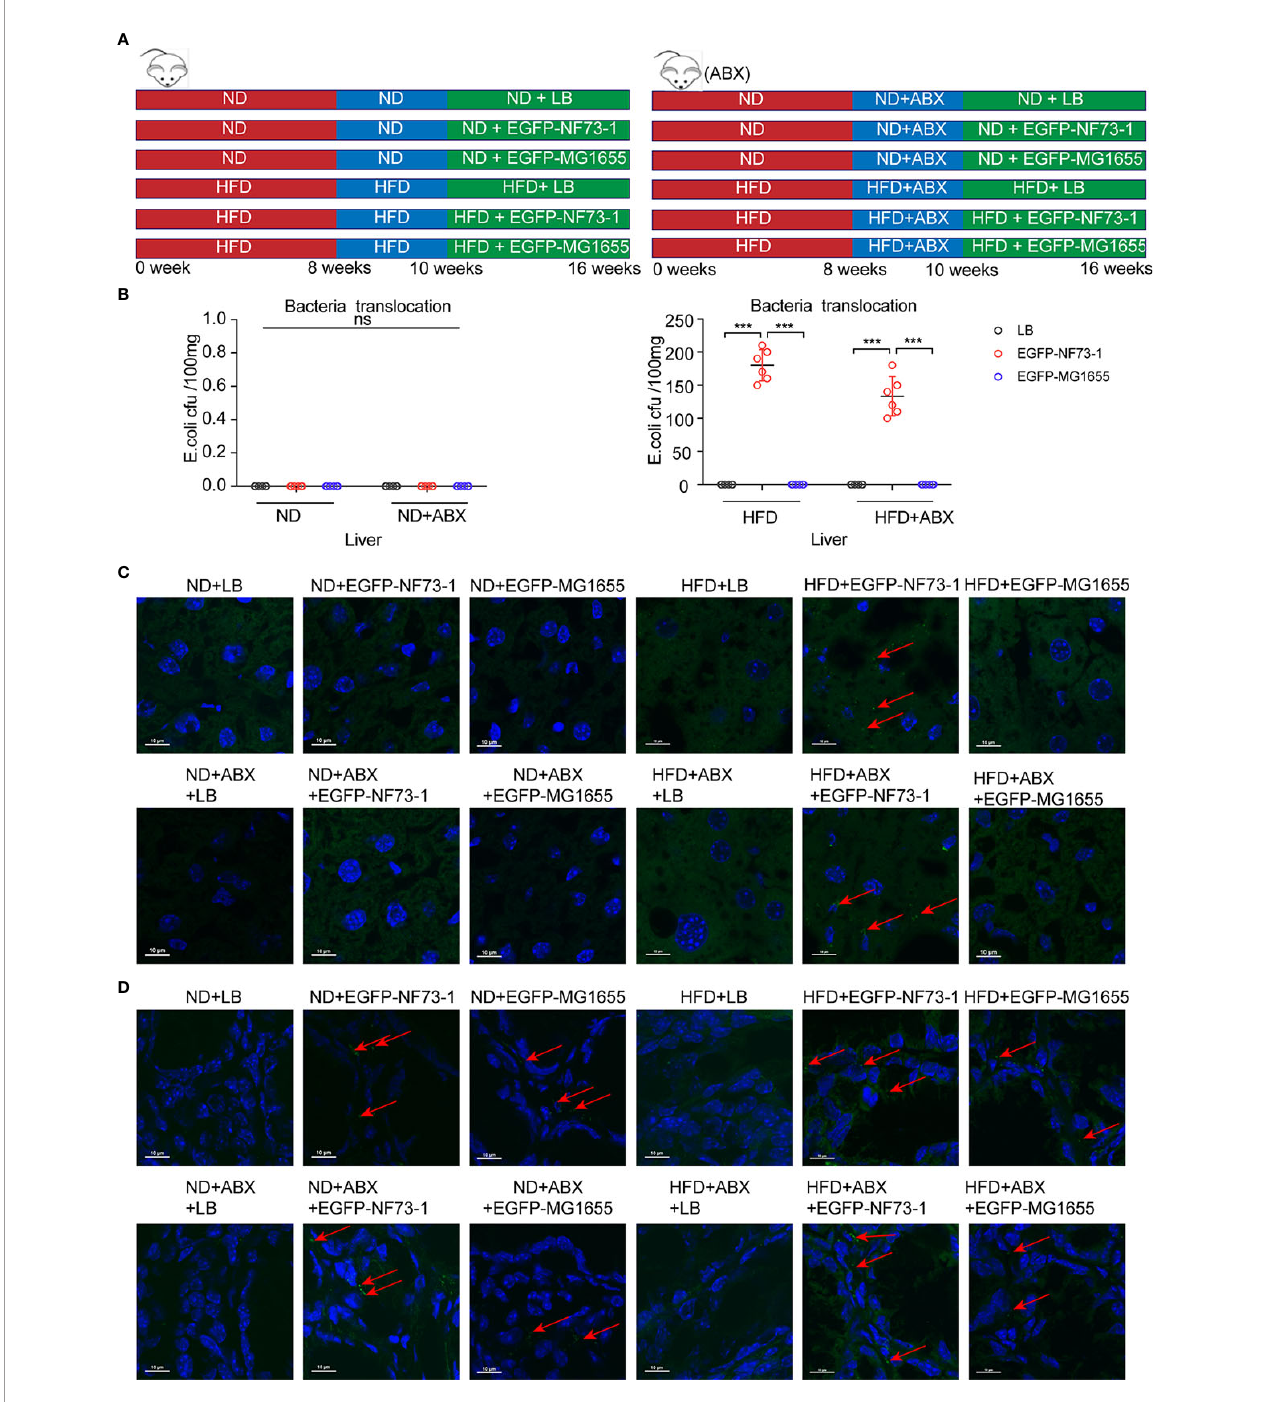
FIGURE 3 | Translocation of E. coli EGFP-NF73-1 into the liver in the HFD-NF73-1 and HFD-ABX-NF73-1 groups and not in the ND-NF73-1 and ND-ABX-NF73-1 groups. (A) Schematic illustration of treatment with E. coli EGFP-NF73-1, E. coli EGFP-MG1655 and LB in ND and HFD mice. (B) Bacterial counts at speci fi c points after oral gavage of NAFLD mice with 10 8 E. coli EGFP-NF73-1 CFU per 0.1 g of liver. (C) Liver section assessment for E. coli EGFP-NF73-1 in mouse experiments. Highly notable EGFP signal in the livers of the HFD-NF73-1 and HFD-ABX-NF73-1 groups (red arrows, EGFP signal). The white scale bar indicates 10 m m. (D) Intestinal section assessment for E. coli EGFP-NF73-1 in mouse experiments (red arrows, EGFP signal); the white scale bar indicates 10 m m. Data are calculated as the mean ± SEM, n = 6 per group. ns p>0.05, ***p <0.001(unpaired t test). EGFP, enhanced green fl uorescent protein; HFD, high-fat diet; ND, normal diet; NAFLD, non-alcoholic fatty liver disease. NS, no signi fi